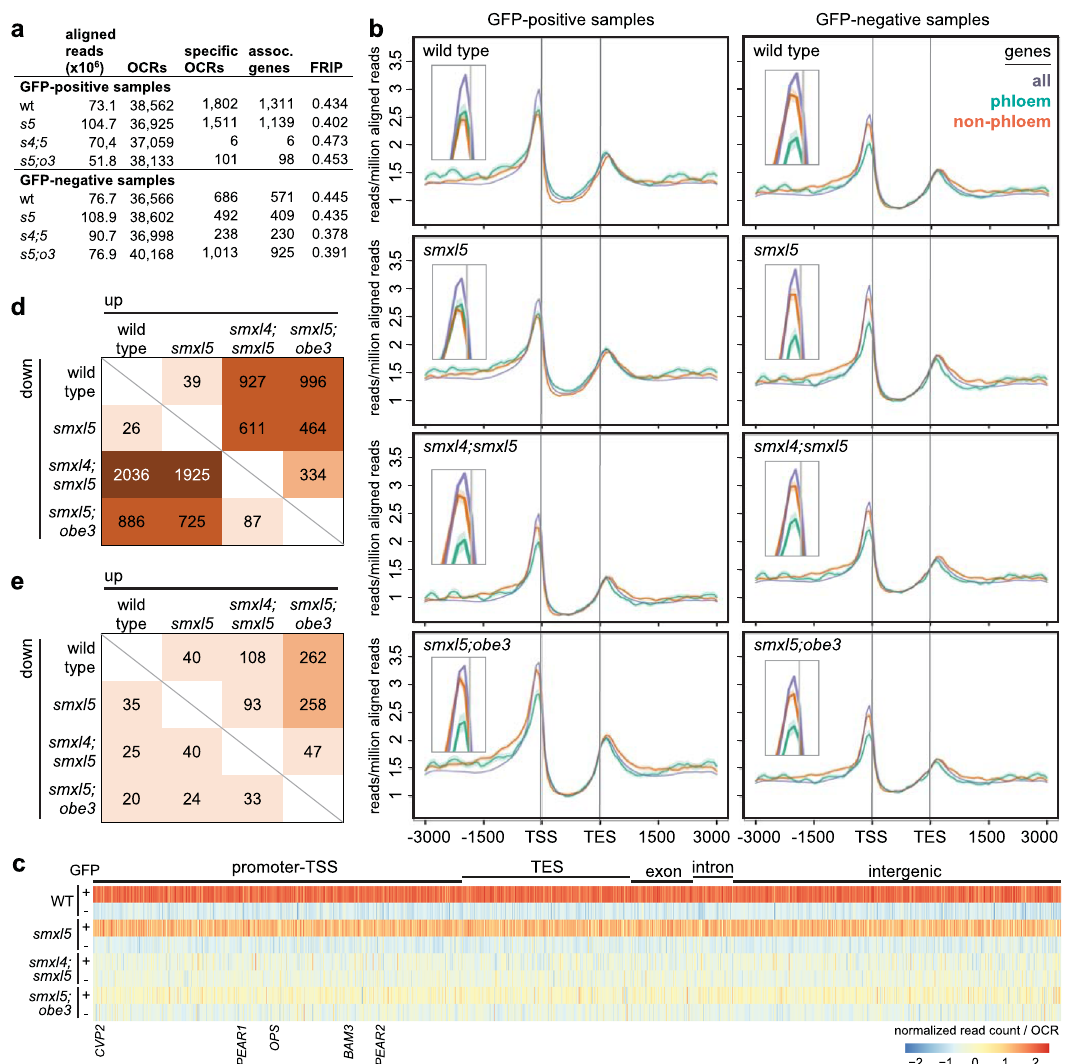
Fig. 8 | SMXL and OBE3 genes determine phloem-related chromatin pro fi le. a Summary of ATAC-seq results for the different samples. Speci fi c OCRs were identi fi ed by comparing GFP-positive and GFP-negative samples of the respective geneticbackgrounds. After initial alignment, OCR detection and other subsequent analyses were conducted using 40M reads aligning to the nuclear genome excluding duplicates for each sample. b Chromatin conformation pro fi les for all genesfoundintheArabidopsisgenomeoronlyforphloemandnon-vasculargenes, accordingtoref.45.Readalignmentwasadjustedtotranscriptionalstartsites(TSS) and transcriptional end sites (TES). X-axes show distance to TSSs and TES in base- pairs. Inserts in all graphs are enlargements of the peaks identi fi ed close to TSSs.